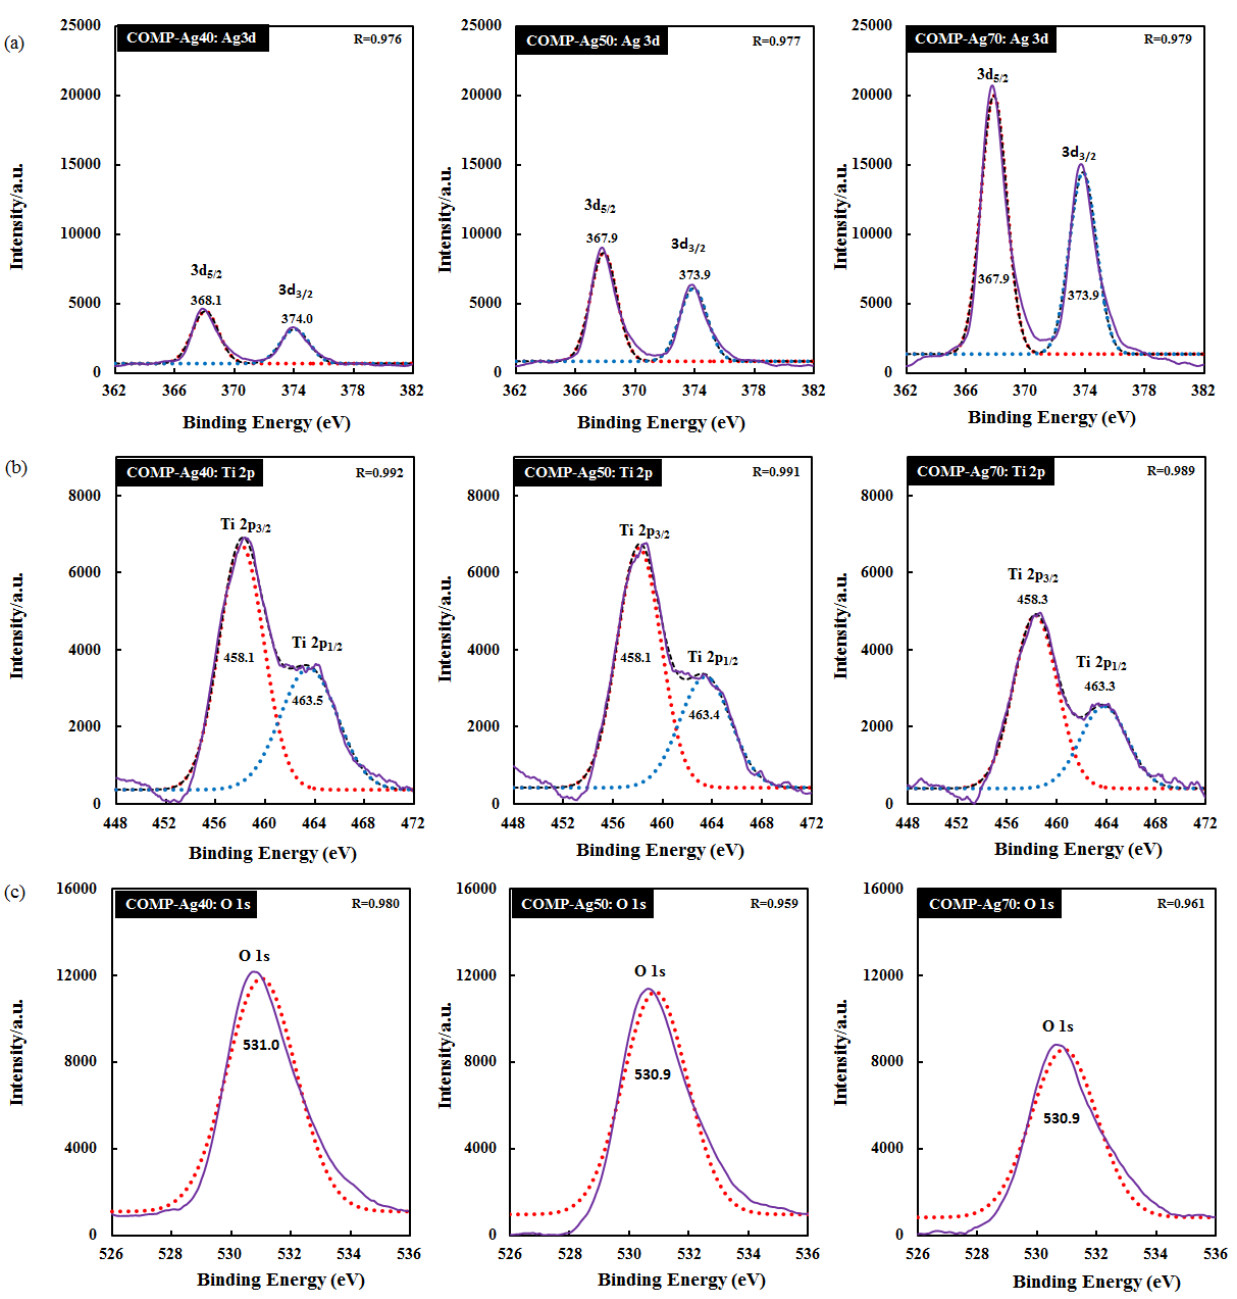
Figure 2. High resolution regional ( a ) Ag3d; ( b ) Ti 2p and ( c ) O 1s XPS spectra. The thin solid lines indicate the original data of XPS. The dashed curves show theoretically fitted curves by assuming Gaussian